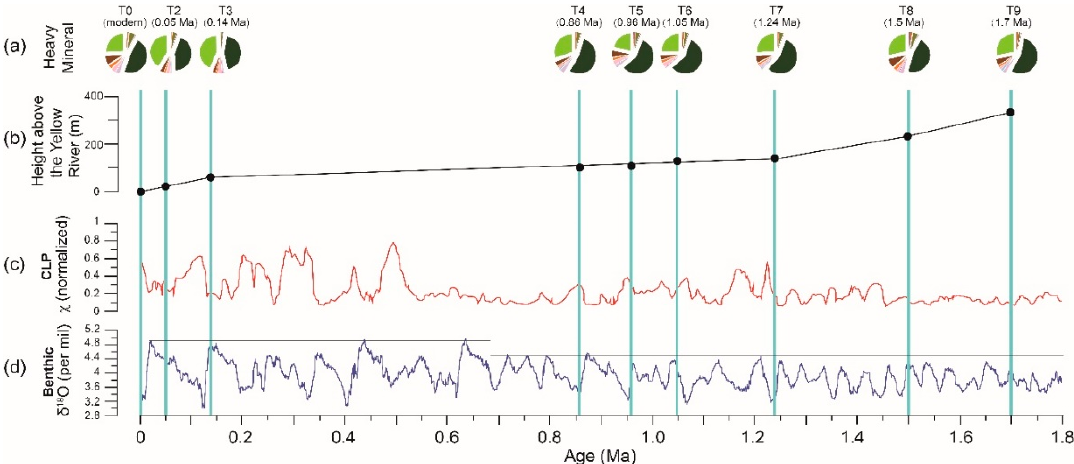
Figure 3. Comparison between heavy-mineral spectra from Yellow River terraces and the paleoclimatic record. ( a ) Heavy-mineral data from Yellow River terraces in the Lanzhou area. ( b ) Correlation between formation age of Yellow River terraces and height above the river (mod. from [10,38]). The less steep slope between T7 and T3 indicates lower rates of rock uplift and river incision at that time. ( c ) Variations of the East Asian summer monsoon during the past 1.8 Ma, based on the stacked magnetic susceptibility ( χ ) records on the Chinese Loess Plateau (CLP) [50]. ( d ) Variations of global ice volume during the past 1.8 Ma, based on the benthic oxygen-isotope record [51]. Mineral color-code as in Figure 2.